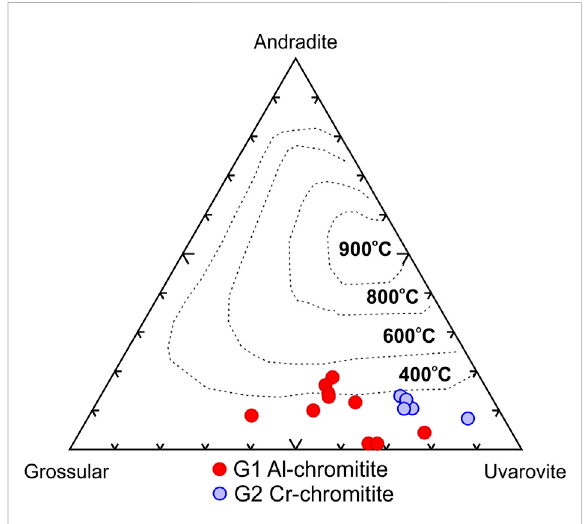
FIGURE 7 TernarydiagramofgarnethostedinG1andG2chromitites,in the grossular-uvarovite-andradite system. Dotted lines represent the stability limits of the aforementioned solid solution, after Melcher et al. (1997) and references